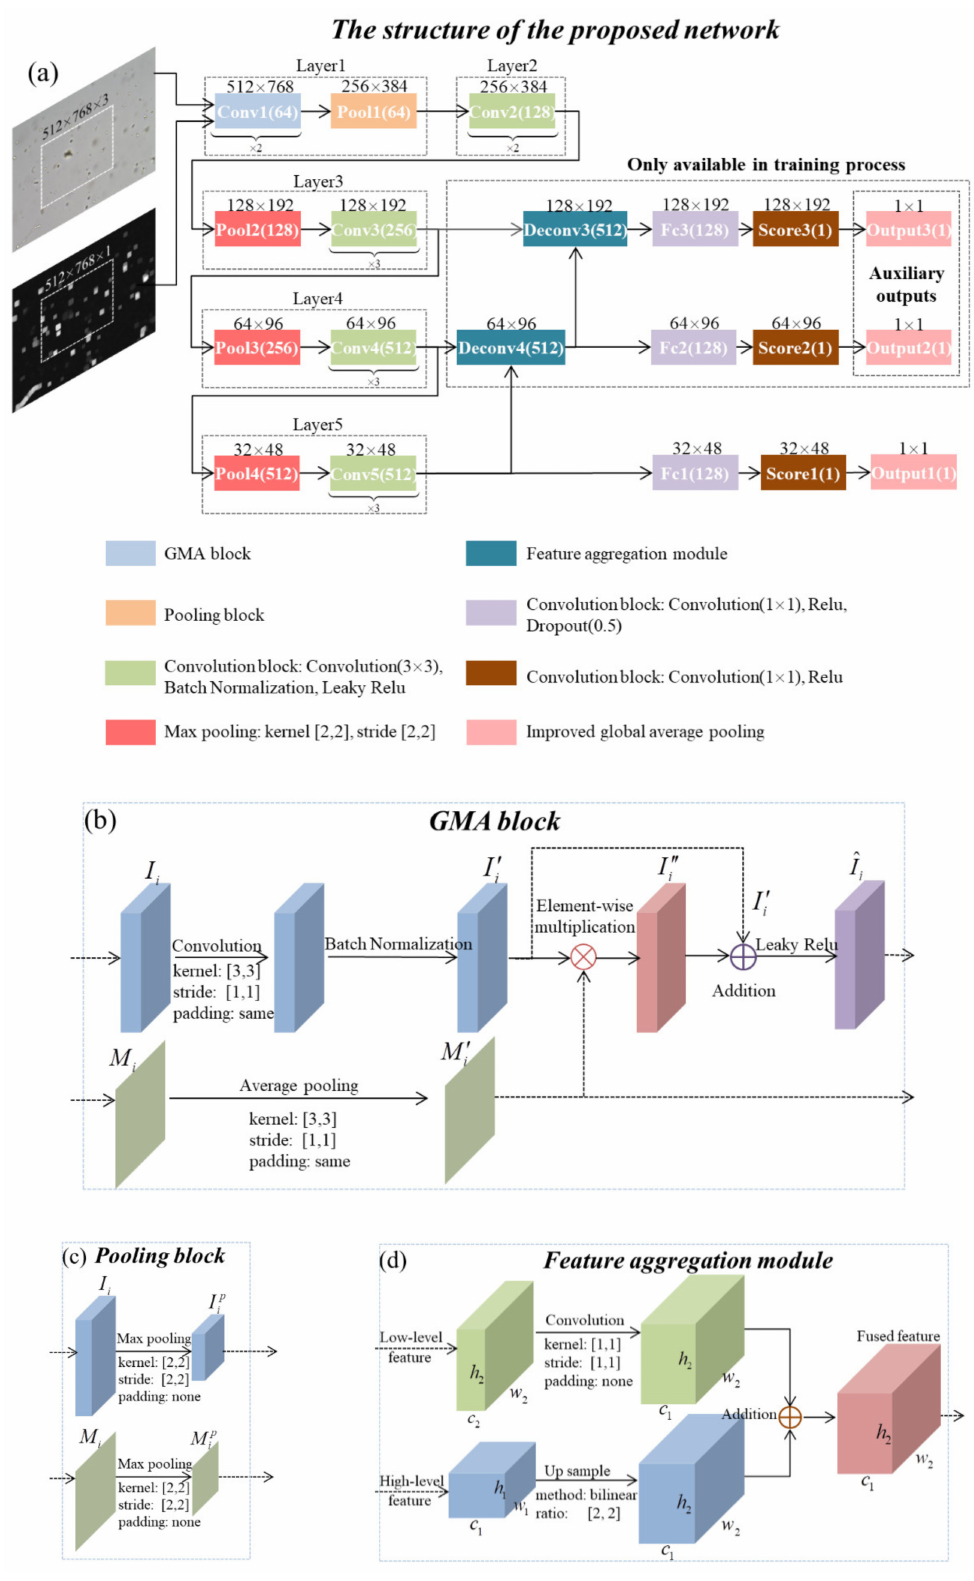
Figure 3. ( a ) The structure of the proposed GMANet. ( b ) The structure of the GMA block. ( c ) The structure of the pooling block. ( d ) The structure of the feature aggregation